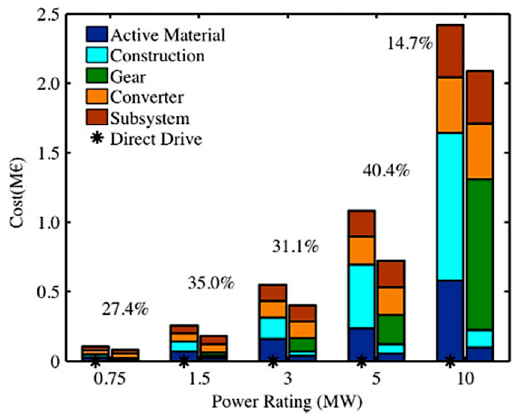
Figure 14. Depicted CAPEX (Capital Expenditure) comparison of geared and gearless PMSGs at a range of power ratings with percentage difference in cost shown at each power level [72].